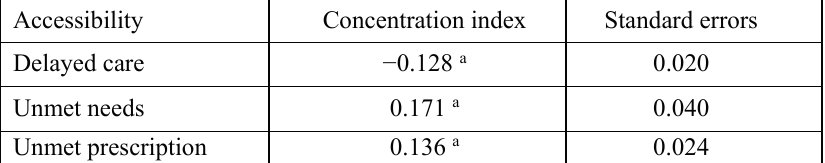
Figure 4. Concentration curves—Access Disparity (Out of Pocket): Generally perceived delay in healthcare (Delayed care), Generally perceived unmet needed health care (Unmet needs), and Unmet needed prescription drug (Unmet prescription) by Out-of-pocket